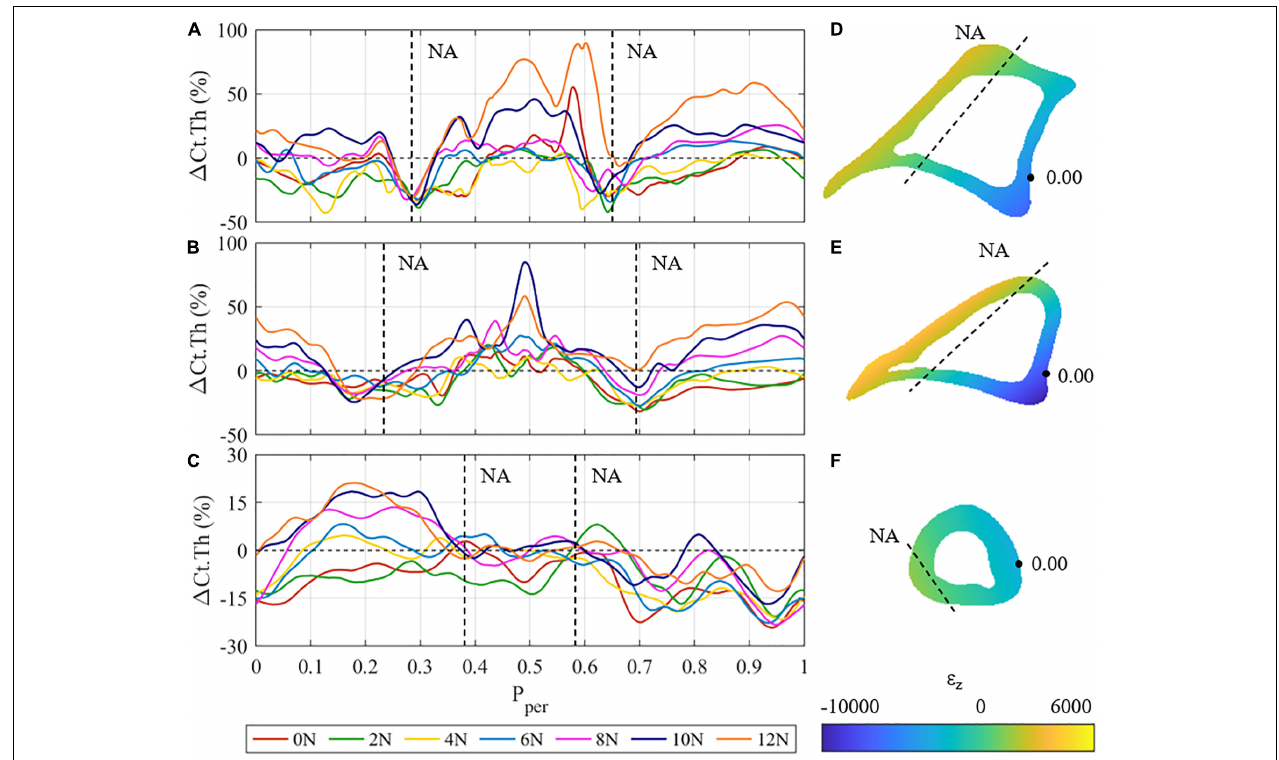
FIGURE 4 | (A–C) Mean cortical thickness changes ( (cid:49) Ct.Th) vs. normalised periosteal position (P per ) at the: (A) proximal, (B) proximal-middle, and (C) distal tibial cross-section for all different loading cases. Vertical dashed lines represent the approximate P per position of the expected neutral axis (NA). (D–F) Beam theory results for the: (D) proximal, (E) proximal-middle, and (F) distal tibial cross-sections. Dashed lines represent the approximate physical locations of the neutral axis ( ε =